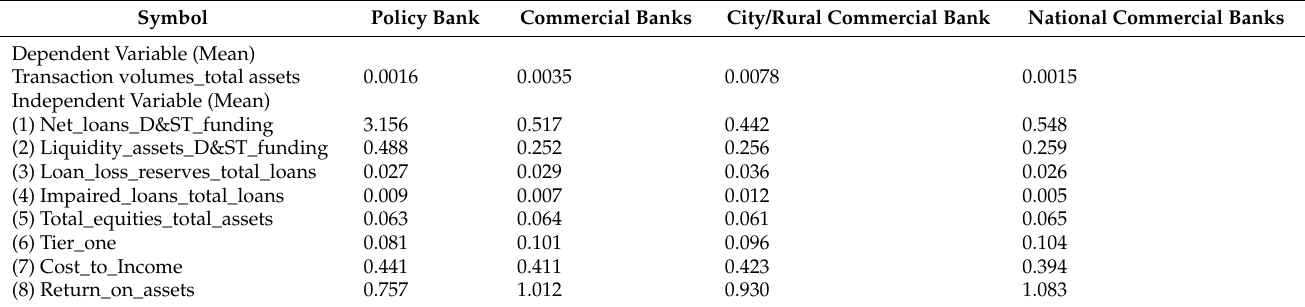
Table 6. Bank-specific determinant variable comparison